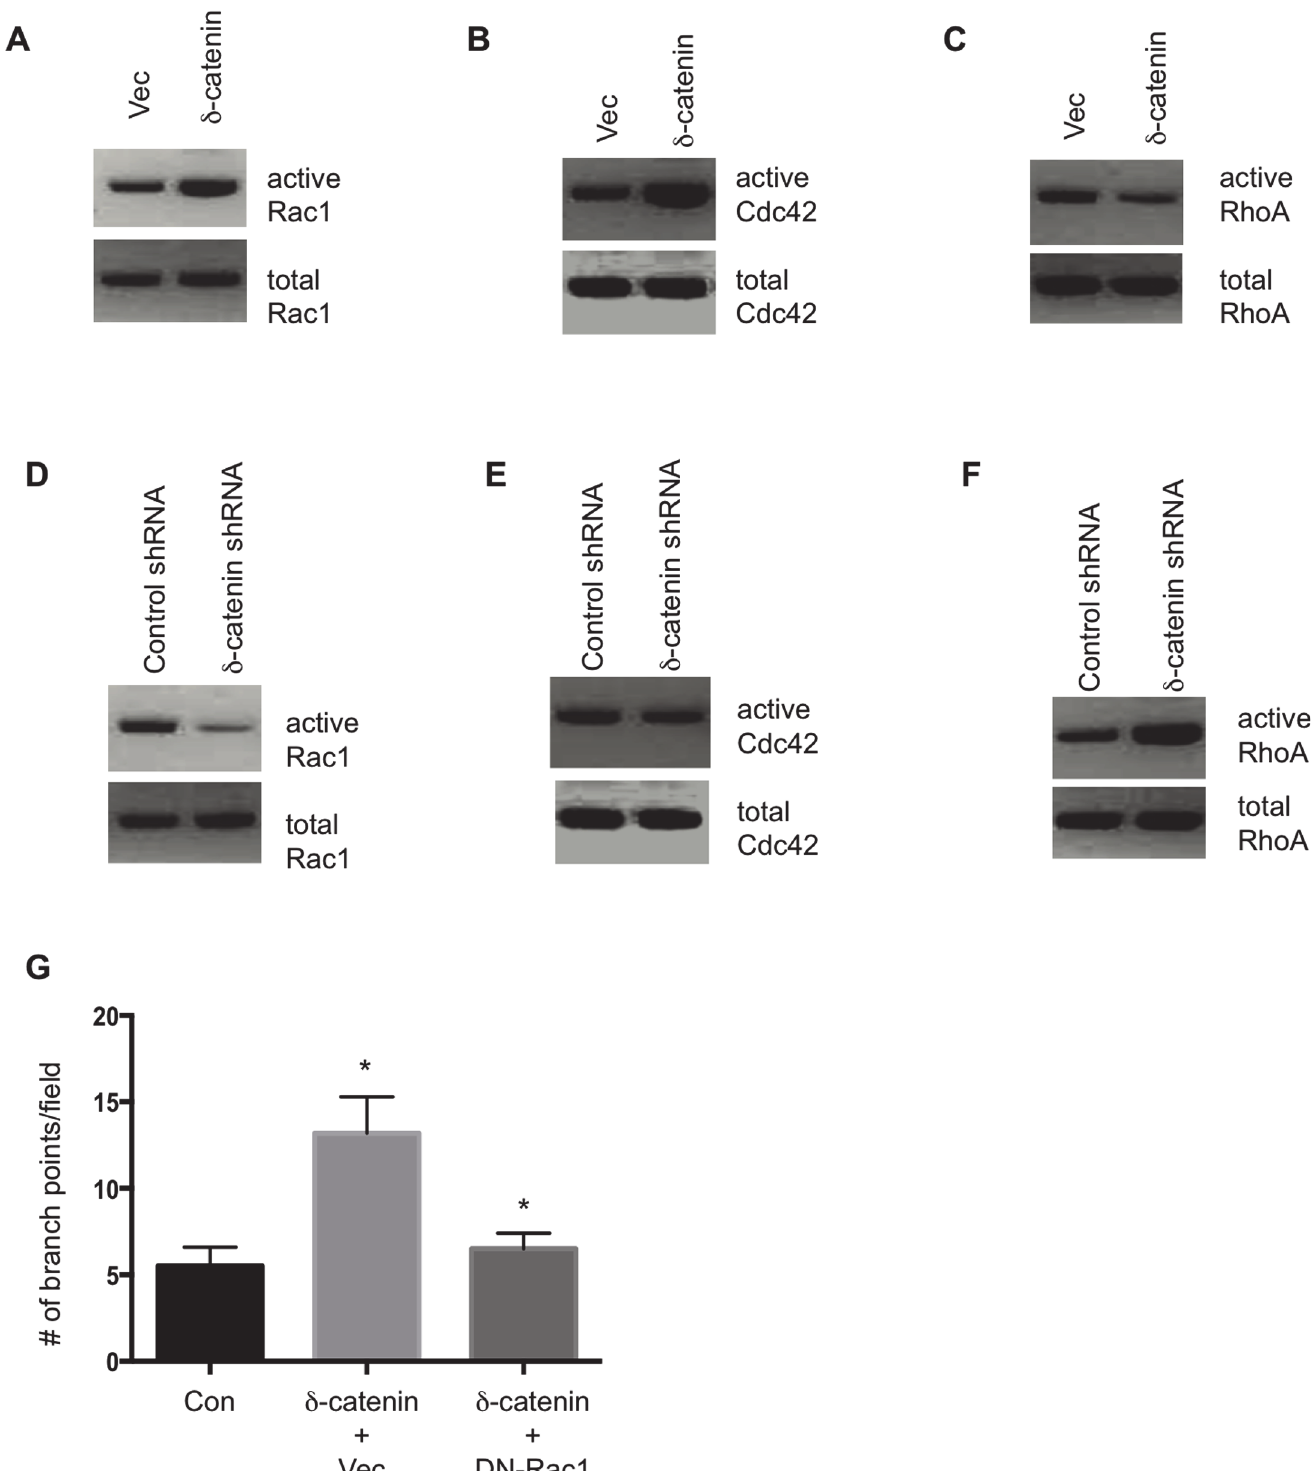
Figure 2. δ -catenin regulates Rho GTPase activity in LECs. HMVEC-LLy cells were transfected with an empty vector or δ -catenin expression vectors for 48 hours. Cell lysate was collected and analyzed for activation of Rac1 (Panel A), Cdc42 (Panel B), and RhoA (Panel C). Activation of Rac1 and Cdc42 was determined by using a PAK1- pull-down assay while active RhoA was pulled down with Rhotekin-agarose beads. For knockdown experiments, HMVEC-LLy cells were transfected with shRNA for δ -catenin or control shRNA constructs for 48 hours. Cell lysate was collected and analyzed for activation of Rac1